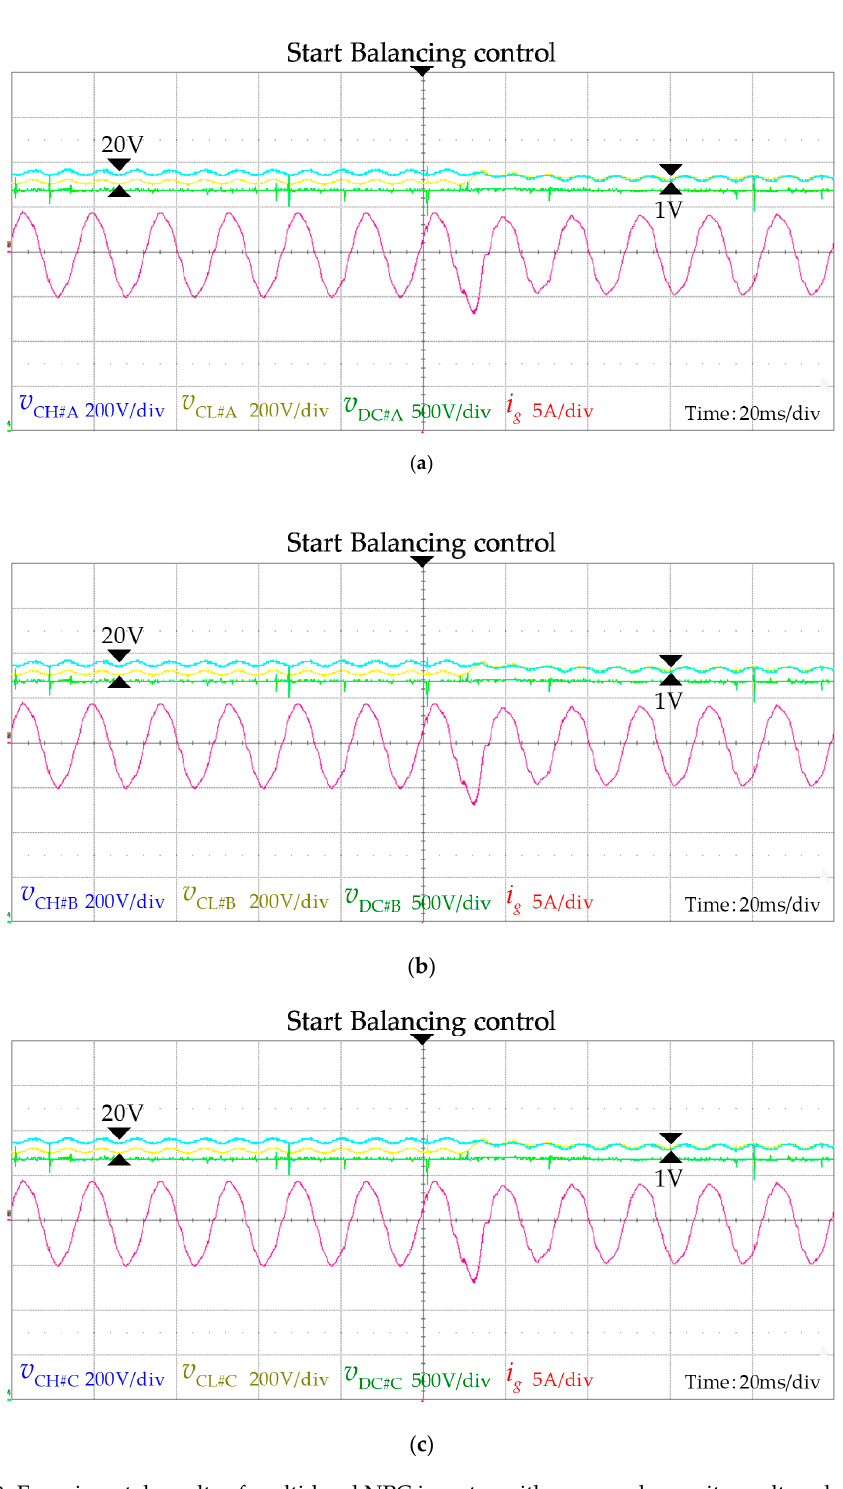
Figure 8. Experimental results of multi-level NPC inverter with proposed capacitor voltage balancing method: ( a ) capacitor voltage imbalance condition in module A; ( b ) capacitor voltage imbalance condition in module B; and ( c ) capacitor voltage imbalance condition in module C.